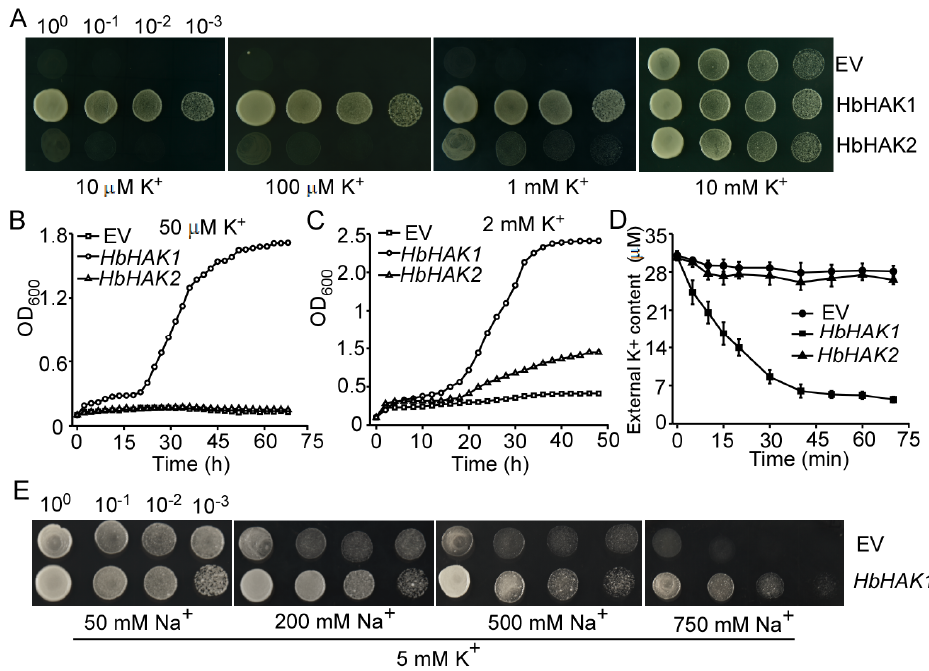
Figure 5. HbHAK1 and HbHAK2 complementation assays in yeast Cyl62 stains. ( A ) Growth of the Cy162 strains with p424 (empty vector), p424- HbHAK1 or p424- HbHAK2 transformed in solid AP-T medium with various K + concentrations. Drop serial dilutions of each strains were cultured on agar plates; ( B , C ) growth curves of the Cy162 strains transformed with p424, p424- HbHAK1 or p424- HbHAK2 in liquid AP-T medium with 50 µ M K + ( B ) or 1 mM K + ( C ) added; ( D ) K + -depletion experiment in the presence of 30- µ M K + in liquid AP-T medium. The Cy162 strains transformed with p424, p424- HbHAK1 or p424- HbHAK2 were subjected to K + starvation for 4 h prior to the beginning of the experiment. The K + content in the bu ff er was measured at intervals over a 2 h period. Three independent experiments were carried out and the data represent the mean ± SD; ( E ) growth of Cy162 strains transformed with p424 and p424- HbHAK1 in solid AP-T medium with various Na + concentrations under 10 mM K + .